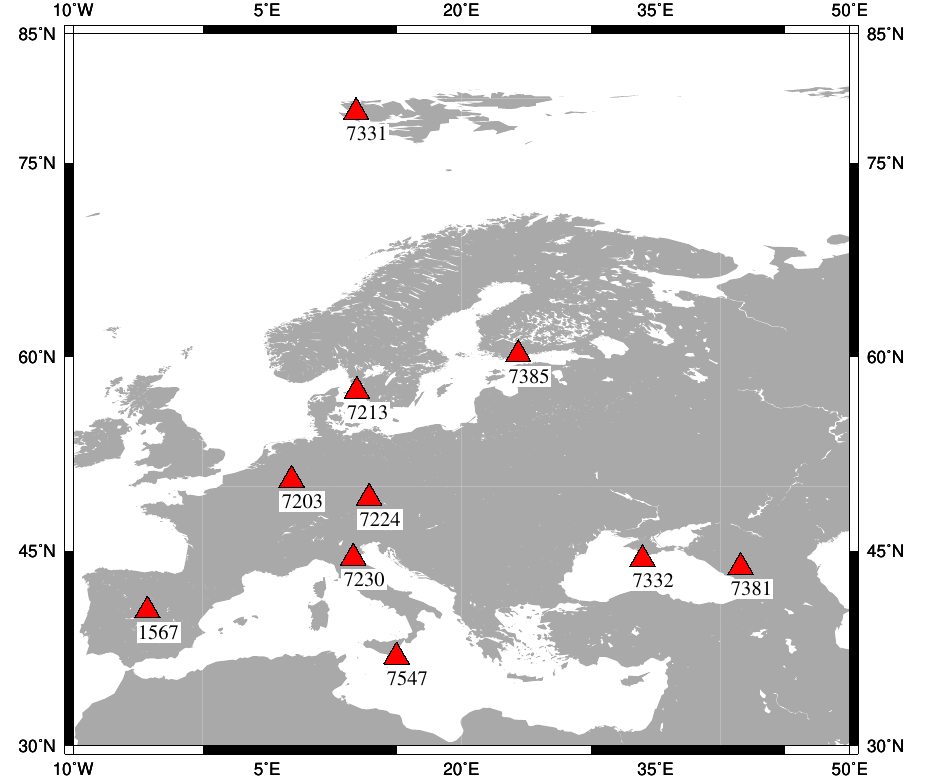
Figure 7. Station distribution of a session with regional coverage. The red triangle represents the VLBI station and its station code in the white